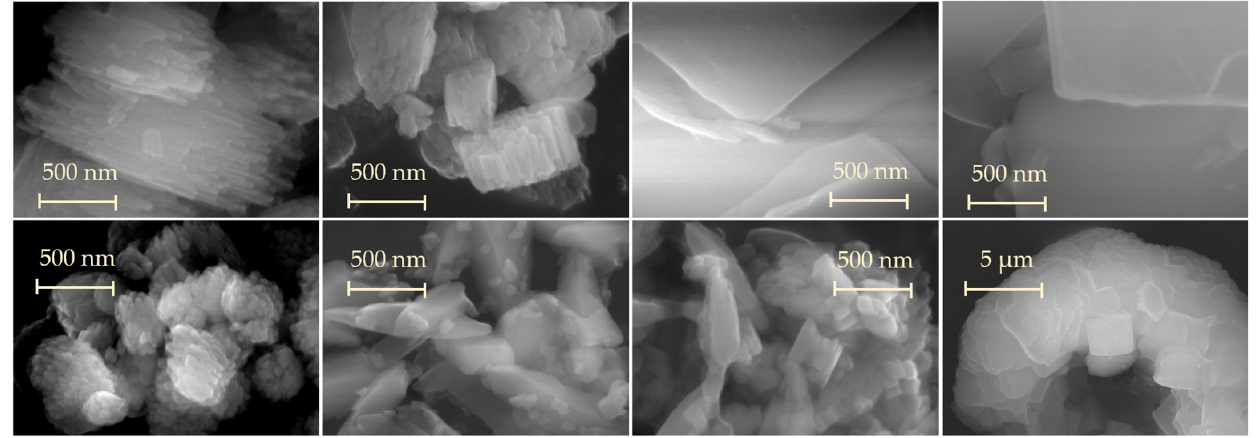
Figure 2. SEM images of the samples. Upper row from left to right: H ‐ MOR ‐ 9.9, H ‐ MOR ‐ 15.0, H ‐ MOR ‐ 15.2 and H ‐ MOR ‐ 15.7; lower row from left to right: H ‐ MOR ‐ 15.8, H ‐ MOR ‐ 18.7, H ‐ MOR ‐ 19.8, and H ‐ MOR ‐ 15.7 in a larger scale.